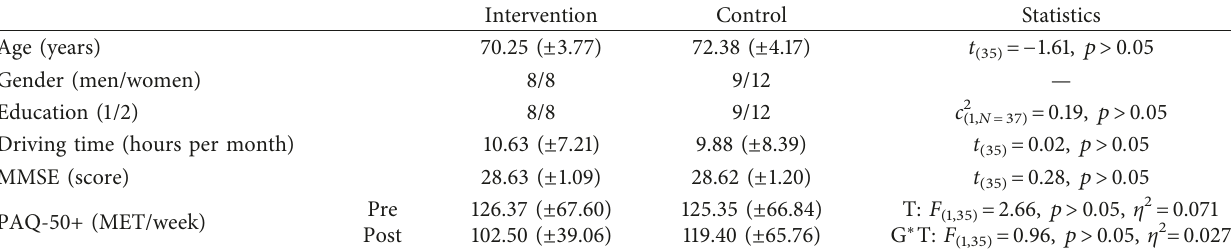
Table 1: Mean values (and standard deviation) of demographic characteristics, MMSE, and PAQ-50+ scores in the intervention and control